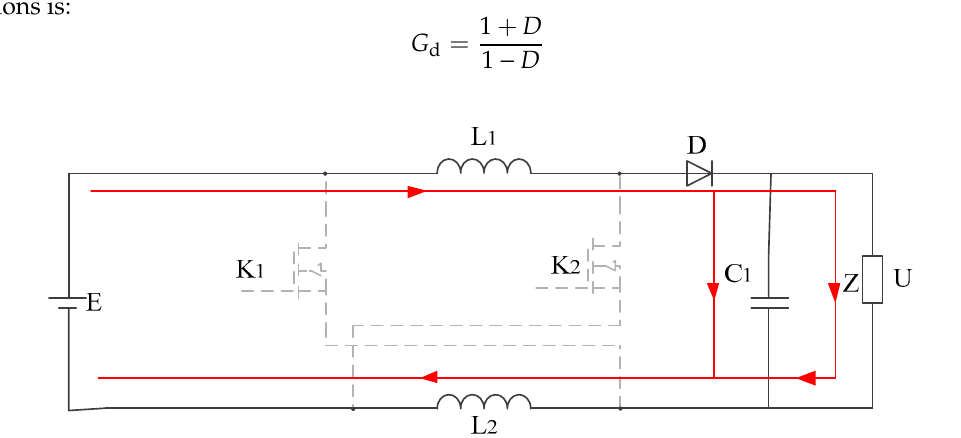
Figure 3. Operating mode of a dual-switch boost converter when the MOSFET is in the OFF state. From Equation (4) of the dual-switch boost converter, the relationship curve between the duty cycle of the switch and the boost ratio of the converter can be obtained, as shown in Figure 4.